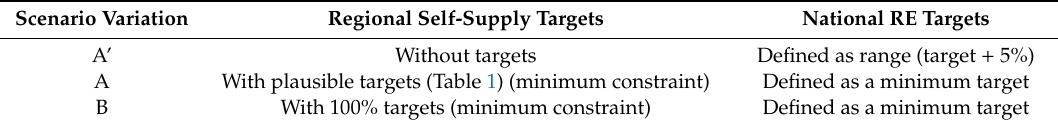
Table 2. Modelled scenario